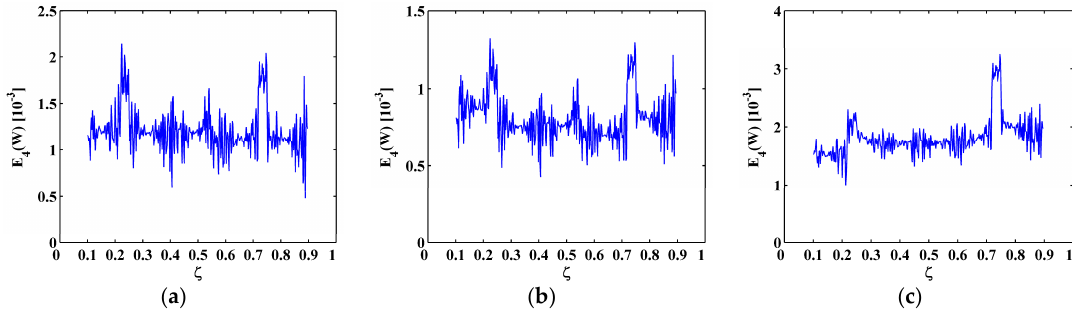
Figure 10. MRM-TKE for the ( a ) sixth; ( b ) seventh; and ( c ) eighth mode shapes with 45 dB SNR.